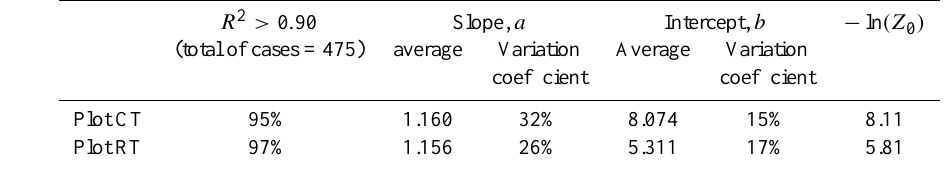
Table 2. Linear regression parameters of the function σ 2 /U 2 ∗ = f ( ln (z)) = a ln (z) + b R 2 > 0 . 90